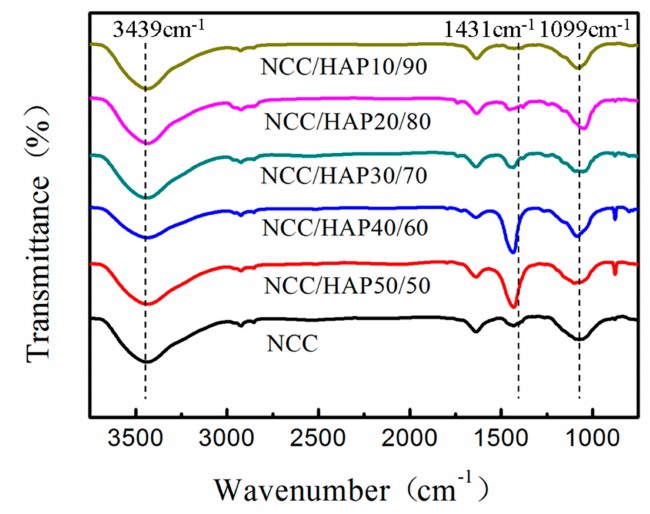
Figure 3. Fourier infrared (FT-IR) spectra of NCC, NCC / HAP50 / 50, NCC / HAP40 / 60, NCC / HAP30 / 70, NCC / HAP20 / 80 and NCC / HAP10 /